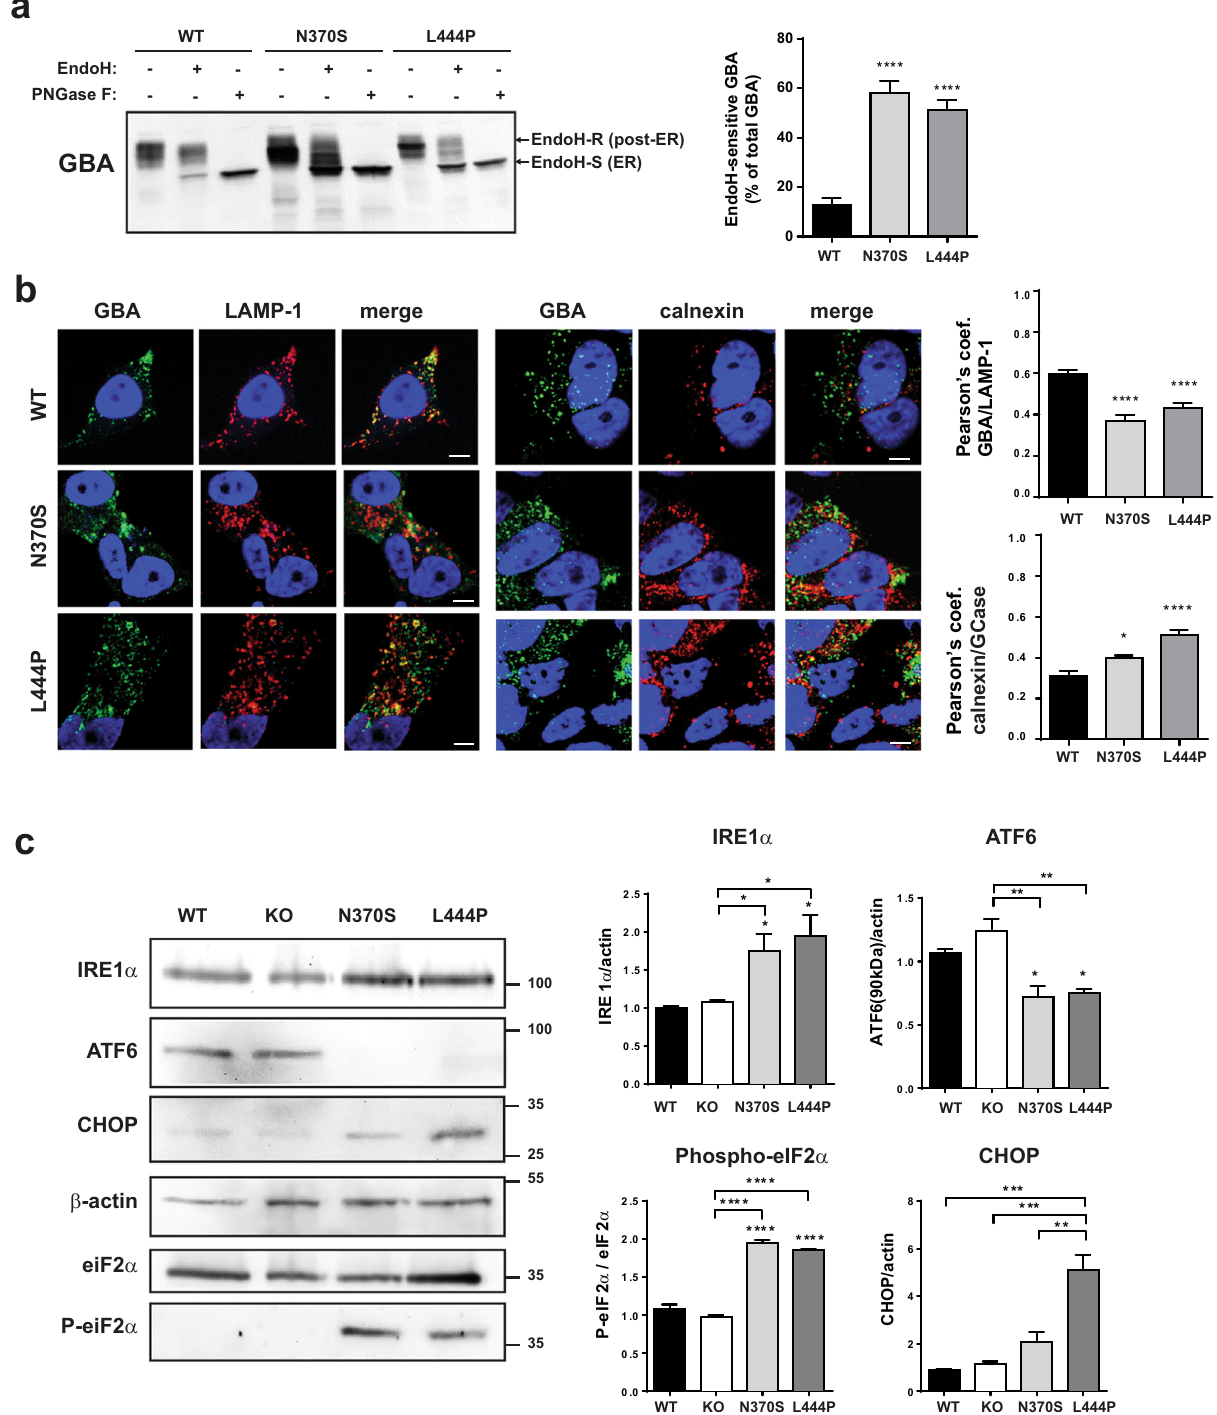
Fig. 2 Mutant GBA proteins are retained in the ER. a Left: representative immunoblots of GBA before and after treatment with EndoH and PNGase F (as a positive control). b Right: quanti fi cation of GBA EndoH-sensitive (EndoH-S) percentage of total GBA protein, n = 8 independent experiments. Representative images and quanti fi cation of the colocalization of GBA with LAMP-1 (lysosomes) and calnexin (ER) determined by immuno fl uorescence. Colocalization was represented as Pearson ’ s coef fi cient (fraction of LAMP-1 or calnexin overlapping GBA), scale bar = 5 µM, n > 20 cells/condition. c Representative immunoblots and quanti fi cation of ER stress markers (IRE1 α , ATF6, phosphorylated eIF2a, and CHOP), n = 3 indepe n dent experiments. In all panels data are presented as mean ± s.e.m, statistical signi fi cance was established at * p < 0.05, ** p < 0.01, *** p < 0.001, **** p < 0.0001 compared to WT samples or between mutant lines when indicated after one-way ANOVA followed by Tukey ’ s multiple comparisons